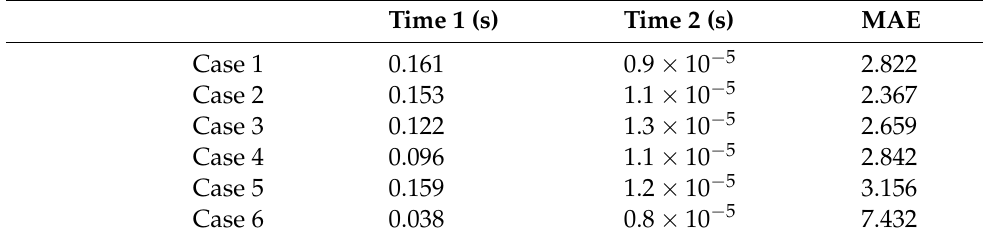
Table 2. Two methods are used to calculate the OAA index of 1000 random tip poses in the sub- workspaces corresponding to the six reachability spheres in Figure 14, then the corresponding average time costs and mean absolute errors are